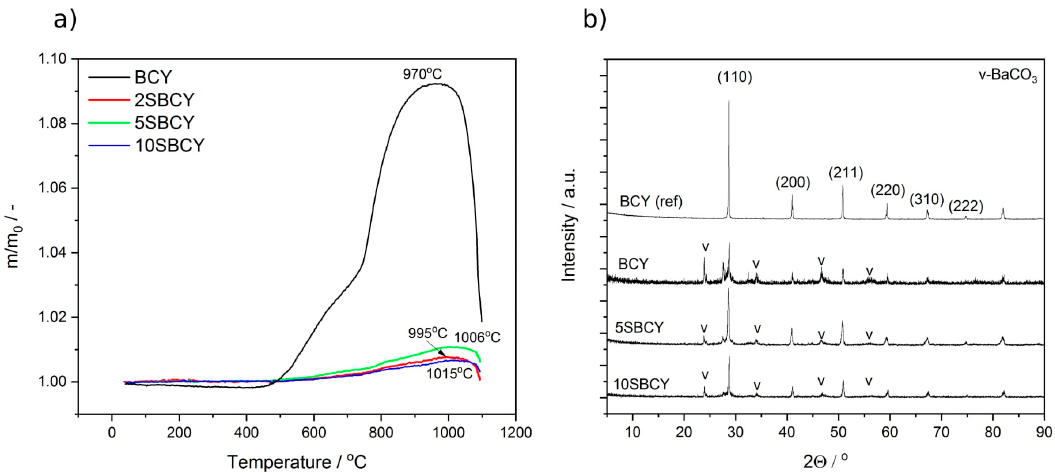
Figure 7. TG curves recorded for Ba 1 − x Sr x Ce 0.9 Y 0.1 O 3 − δ samples in a pure CO 2 gas atmosphere, at temperatures ranging from 25 to–1100 °C ( a ); XRD pattern recorded for SBCY samples after heating in 5 vol.% CO 2 in an Ar gas atmosphere at 550 °C for 100 h ( b ).